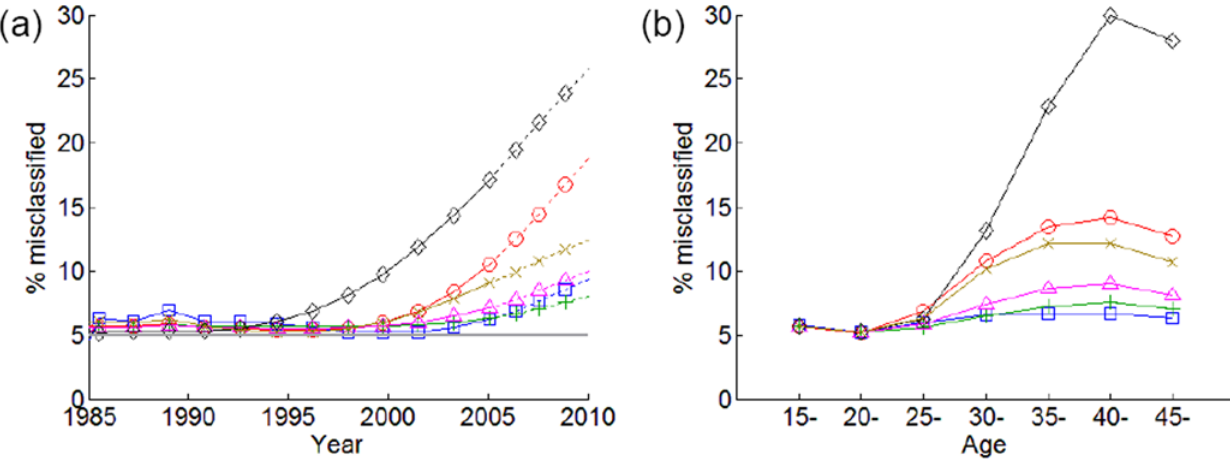
Figure 3. Proportions of infections at least one year old that are misclassified by the BED test for six African countries, (a) over time (ages 15–49), and (b) over age (in year 2005) using BED response scenario B (increasing proportion false positive: panels c & f). Lines show: Kenya (red line and circles), Lesotho (blue line and squares), Mozambique (green line and plus-signs), Nigeria (pink link and triangles), Uganda (black lines and diamonds), and Zambia (brown line and crosses). The lines are dotted after 2005, since Spectrum incidence were not calculated after 2005: these results are based on assuming incidence remains constant at 2005 levels.